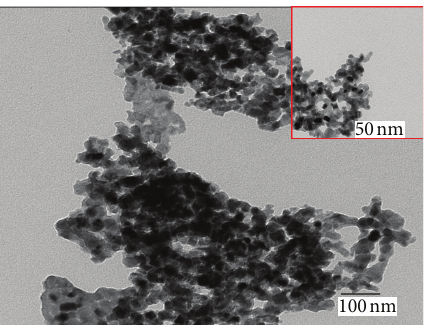
Figure 5: TEM image of BSA-ZnWO 4 nanocomposite (inset is TEM image at higher magnification).